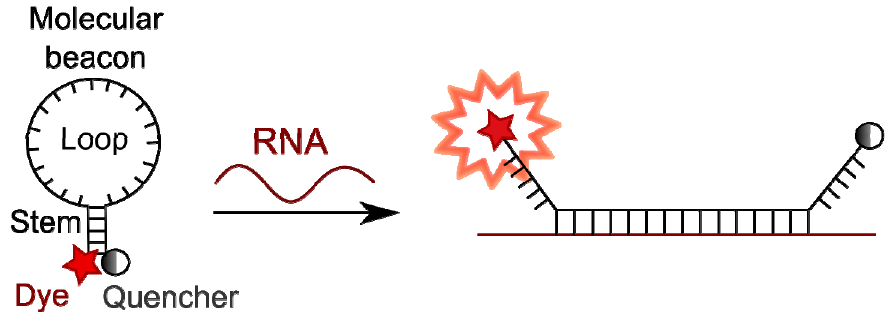
Figure 13. Mode of functioning of molecular